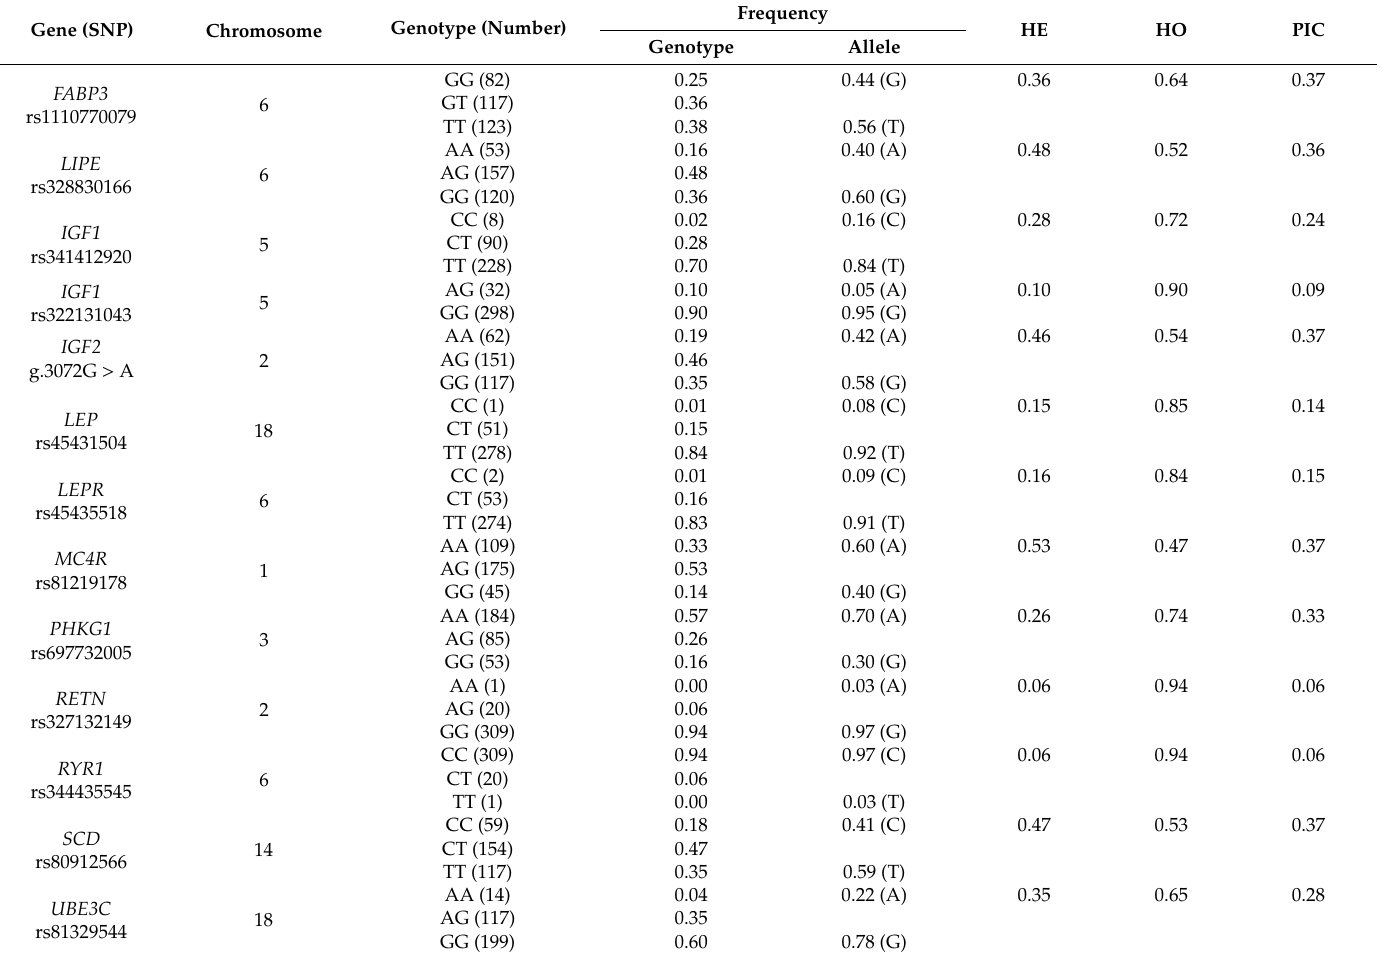
Table 2. Genetic parameters of 13 SNPs in 12 previously reported candidate genes for IFC of Suhuai